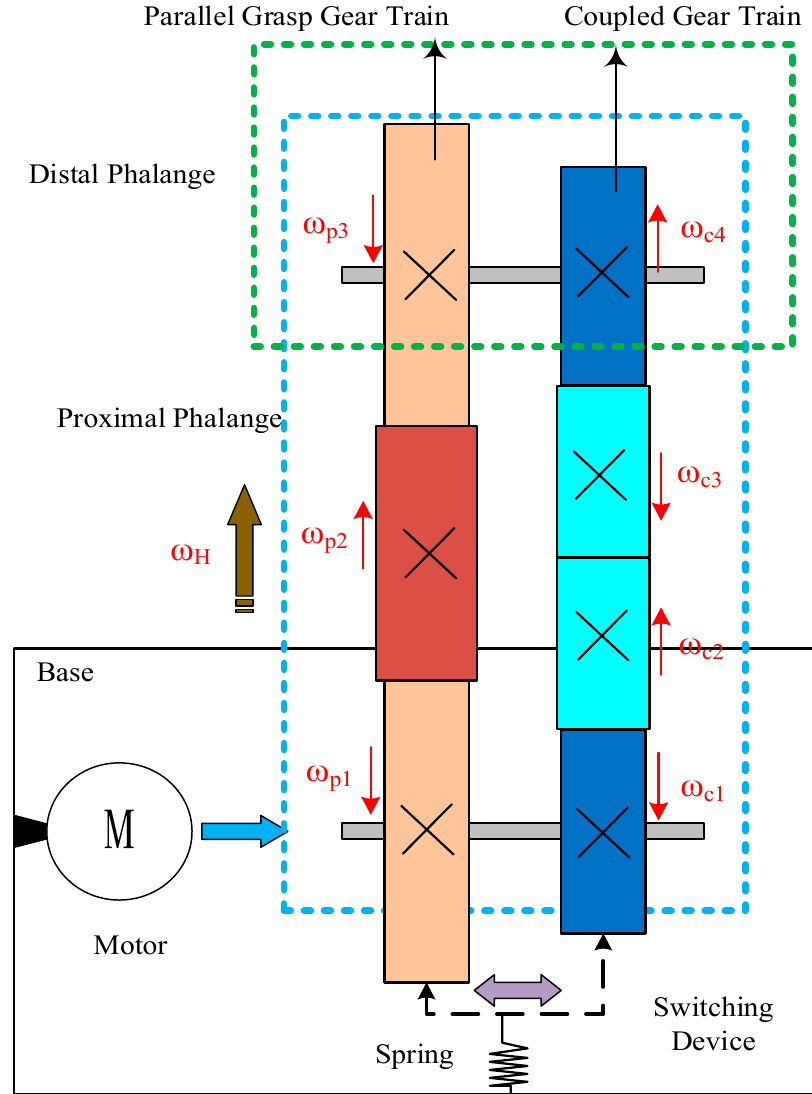
Figure 2. Working principle diagram of the switchable CPS (coupled, parallel, and self-adaptive grasping) mechanism.